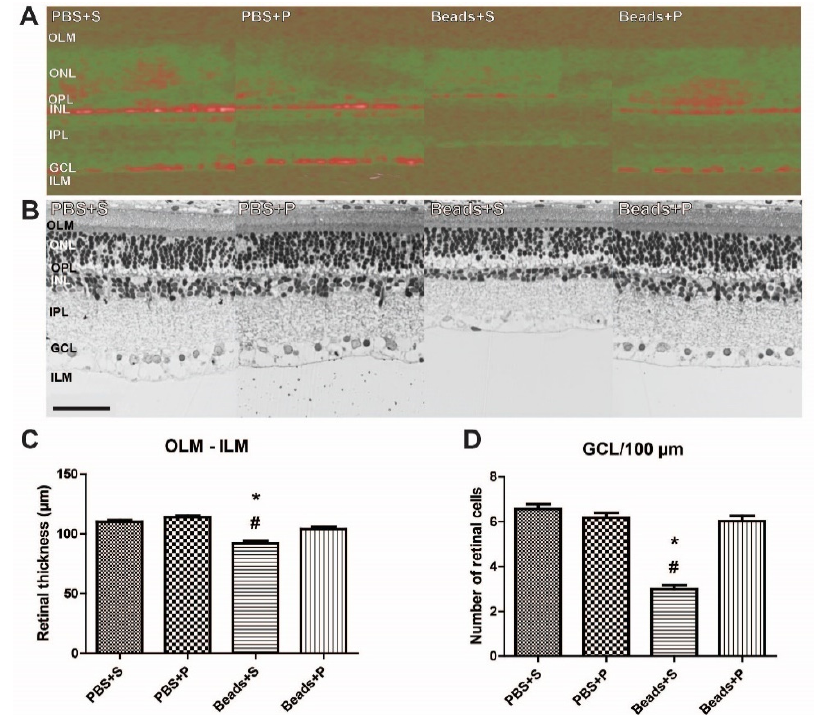
Figure 2. ( A ). Optical coherence tomography (OCT) shows the retinal layers in the four examined groups (PBS + S, PBS + P, Beads + S, Beads + P). In the OCT, retinal structure showed severe degeneration in the Beads + S group compared to the controls. A significant amelioration of the retinal structure was found after PACAP1-38 administration (Beads + P). ( B ) . Representative light microphotographs of retinal sections in all groups. Retinal tissue from Beads + S group showed severe degeneration compared to PBS-injected retinas. The retained retinal structure following PACAP1-38 treatment (Beads + P) was similar to the control (PBS + P) retina. ( C , D ). Morphometric analysis of microbead-induced retinal damage. The degree of microbead-induced retinal neuronal degeneration and the neuroprotective effects of PACAP1-38 eye drops treatment were quantified by the cross-section of the retina from the outer limiting membrane to the inner limiting membrane (OLM–ILM), and the number of cells/100 µm ganglion cell layer (GCL) length. Values are expressed in mean ± SEM, analyzed by ANOVA and Fisher’s post hoc test. * Beads + S vs. PBS + S p < 0.05; # Beads + S vs. Beads + P p < 0.05. Bar: 50 µm. (Abbreviations: PBS: phosphate-buffered saline; S: Systane; P: